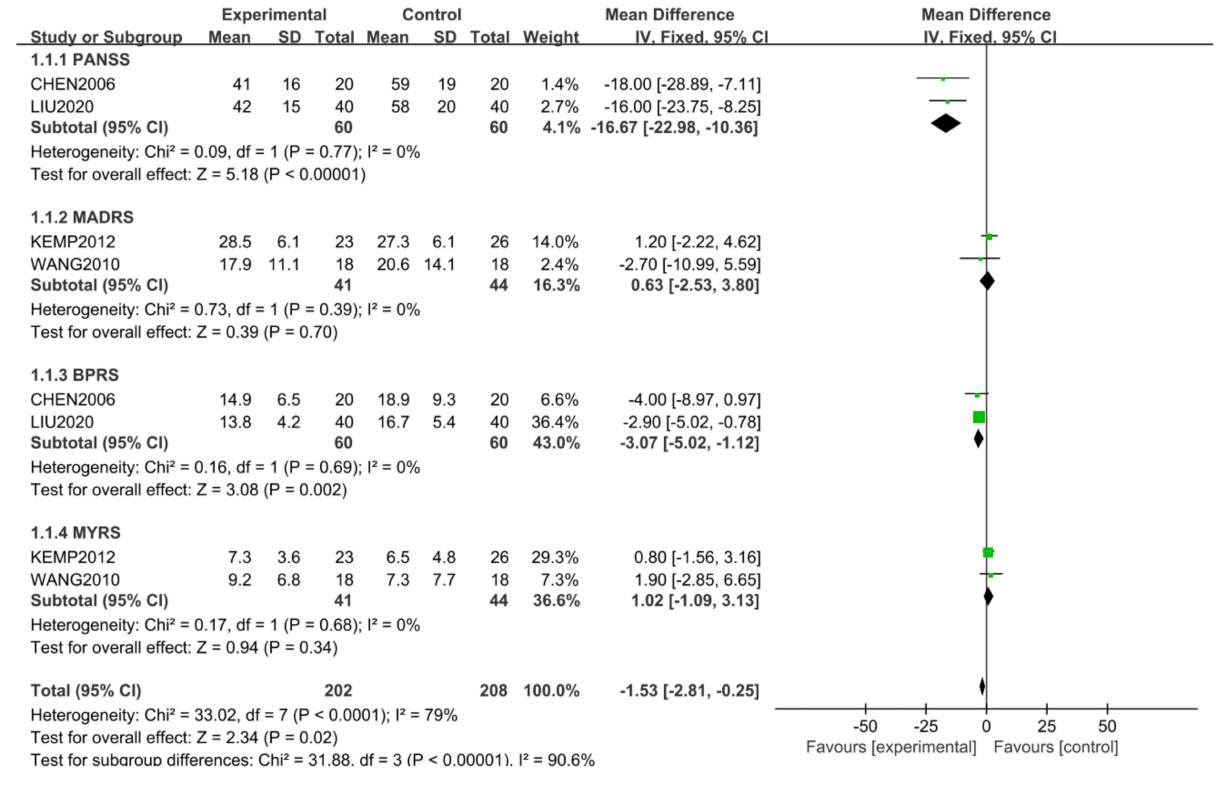
FIGURE 2 | Comparison of different mental symptoms between the study and control groups. The comprehensive analysis shows that the study group had significantly lower score in mental symptoms than the control group ( Z = 2.34, P = 0.02) with a random-effects model ( X2 = 33.02, df = 7, P < 0.01). However, the differences were only shown in PANSS (Z = 5.18, P < 0.01) and BPRS (Z = 3.08, P < 0.01), and not in MADRS ( Z = 0.39, P > 0.05) and YMRS (Z = 0.94, P > 0.05).